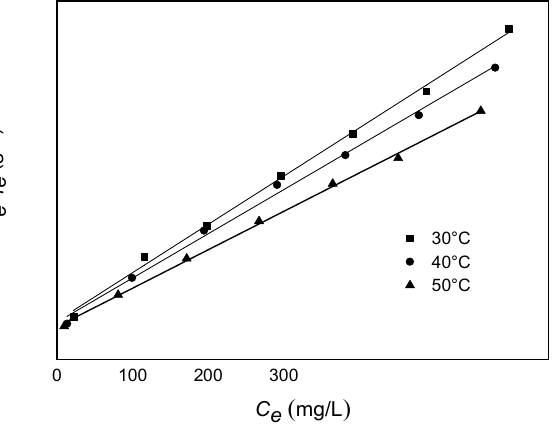
Figure 1. Langmuir isotherms for adsorption of MB onto CnSAC .